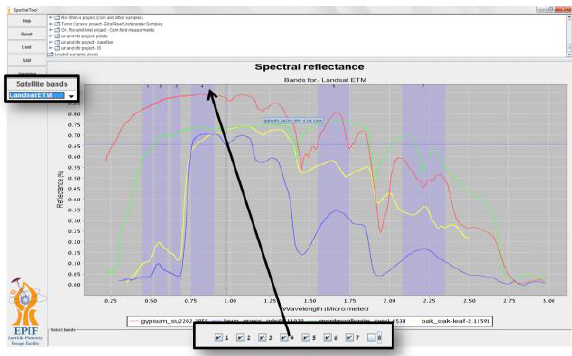
Figure 2. Available band list.